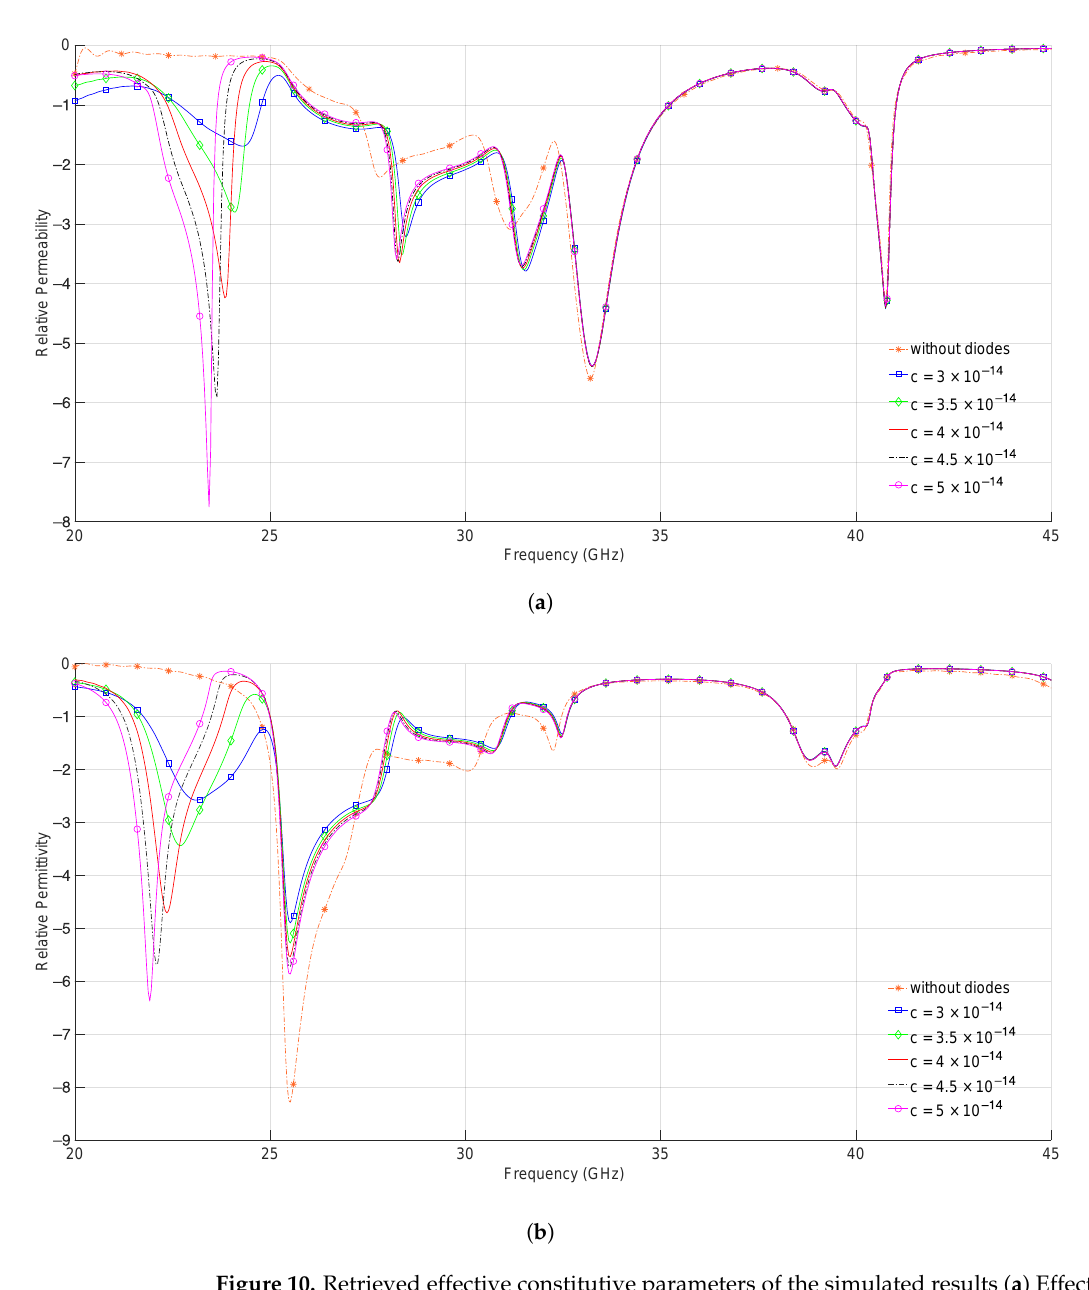
Figure 10. Retrieved effective constitutive parameters of the simulated results ( a ) Effective perme- ability ( b ) Effective